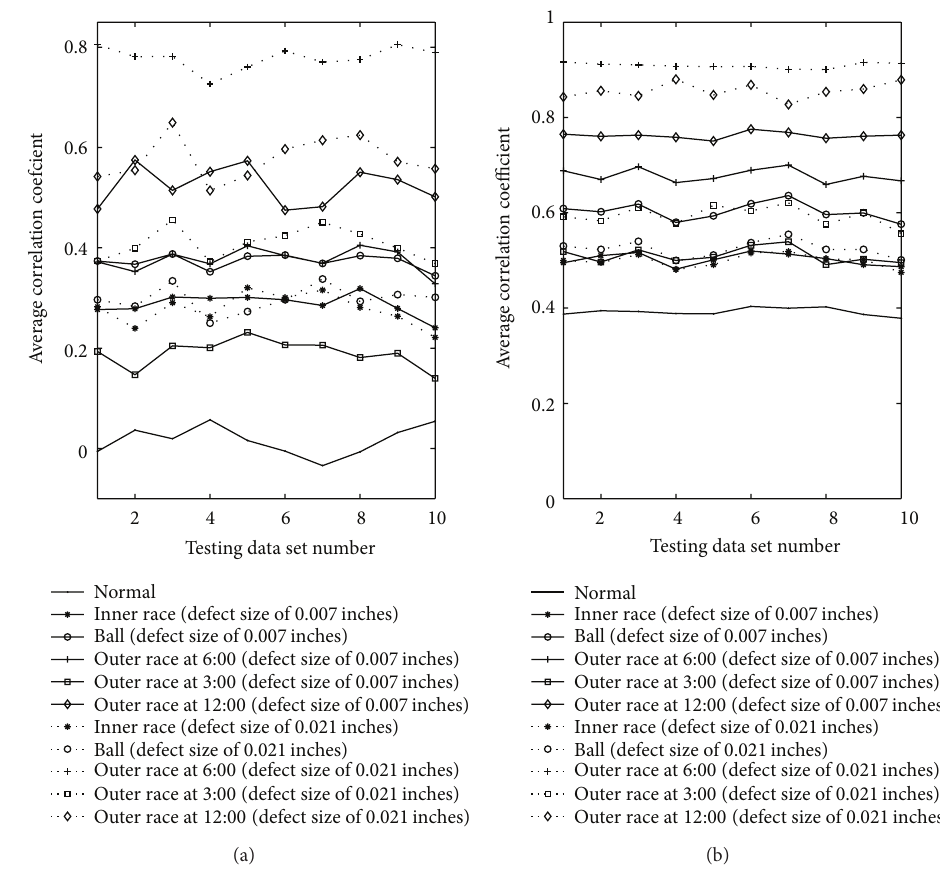
Figure 16: Detection of outer race fault at 6:00 with defect size of 0.021 inches according to morphology spectrum correlation analysis: (a) signal based triangular SE; (b) flat